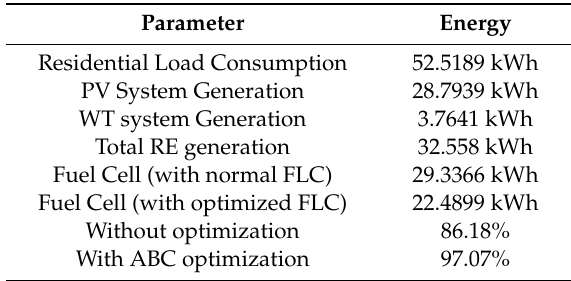
Table 5. Total microgrid energy analysis and system energy saving e ffi ciencies on 28th of July 2016.